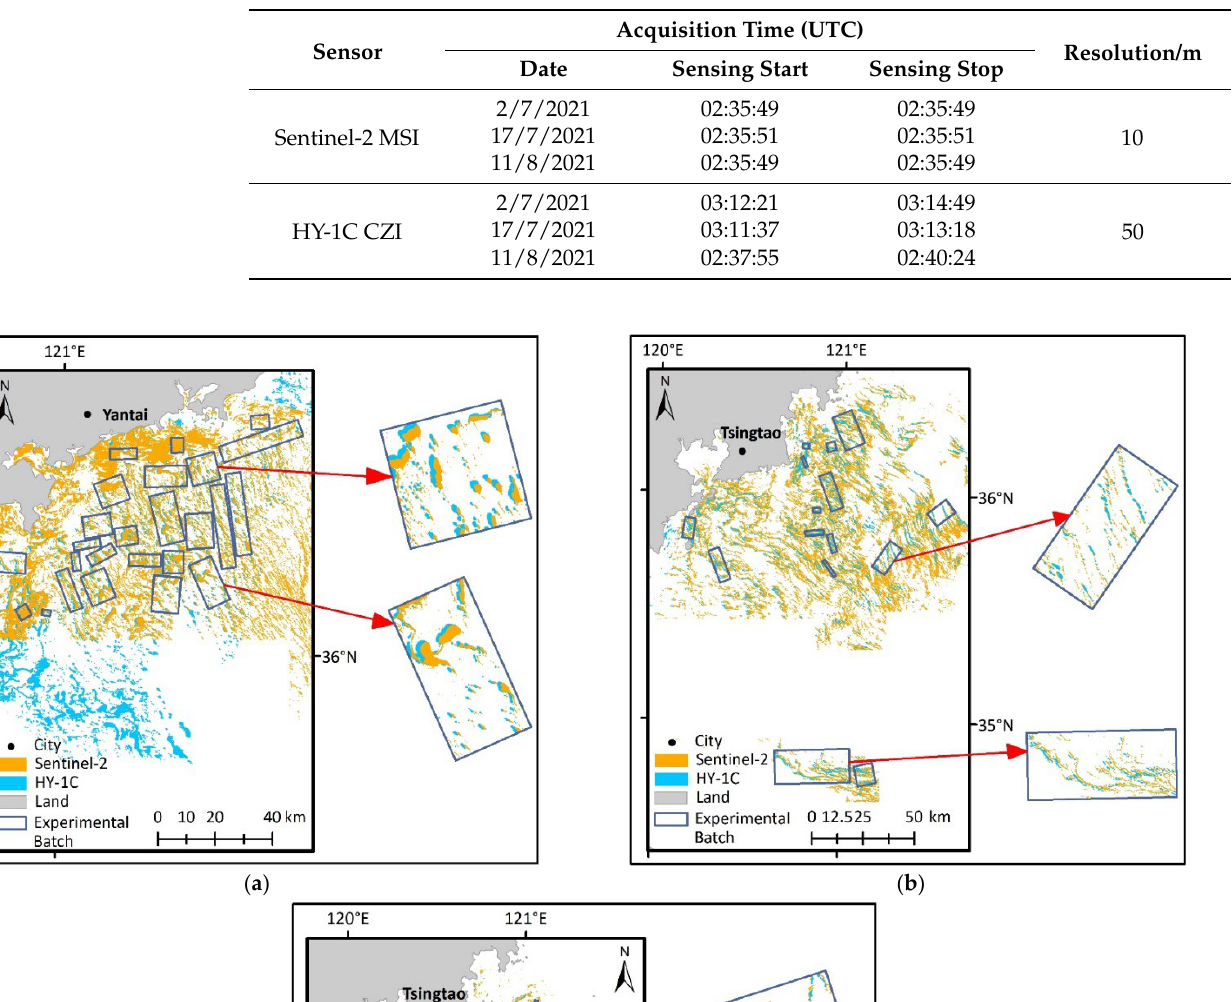
Table 2. Information of the near-coincident HY-1C and Sentinel-2 satellite images.